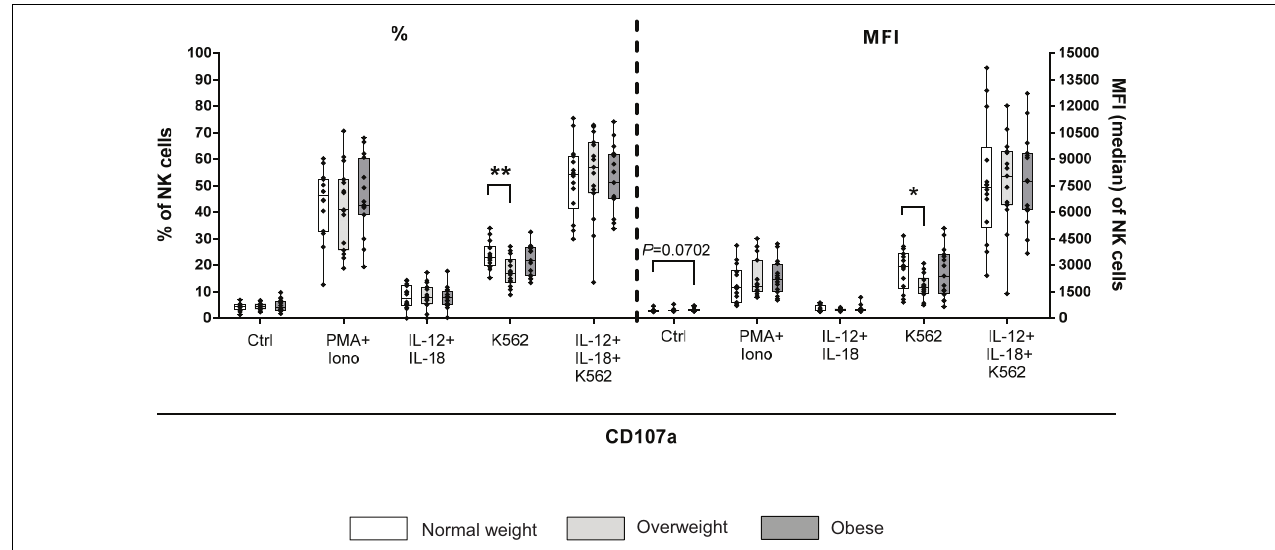
Normal weight Overweight Obese FIGURE 8 | CD107a degranulation assay upon stimulation of PBMCs derived from blood donors with different body mass indexes [normal weight ( n = 14), overweight ( n = 15), and obese ( n = 16)] either with 50 ng/ml phorbol-12-myristate-13-acetate (PMA) in combination with 1 µ g/ml ionomycin for 4 h or with 10 ng/ml interleukin (IL)-12 in combination with 50 ng/ml IL-18 overnight or stimulation with K562 target cells at 15:1 effector to target ratio for 4 h or with the combination of IL-12 plus IL-18 overnight followed by K562 challenge prior to CD107a staining. Unstimulated samples with CD107a staining were included to detect spontaneous degranulation. Percentage and mean fluorescent intensity (MFI) of CD107a + total NK cells are given. Graphs are box and whisker plots with median ± minimum to maximum value; with additional dot plot representing individual donors. Overweight and obese groups were compared to normal weight control group within each stimulation setting. Statistical significance is indicated as: * P ≤ 0.05; ** P ≤ 0.01; P value within 0.05 ≤ P ≤ 0.1 is indicated with precise P -value. Ctrl: unstimulated